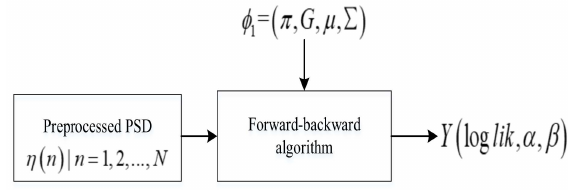
Figure 5. Schematic of the HMM state